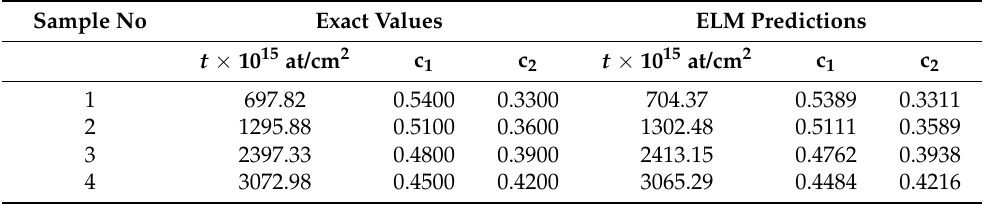
Table 1. ELM predicted results and exact